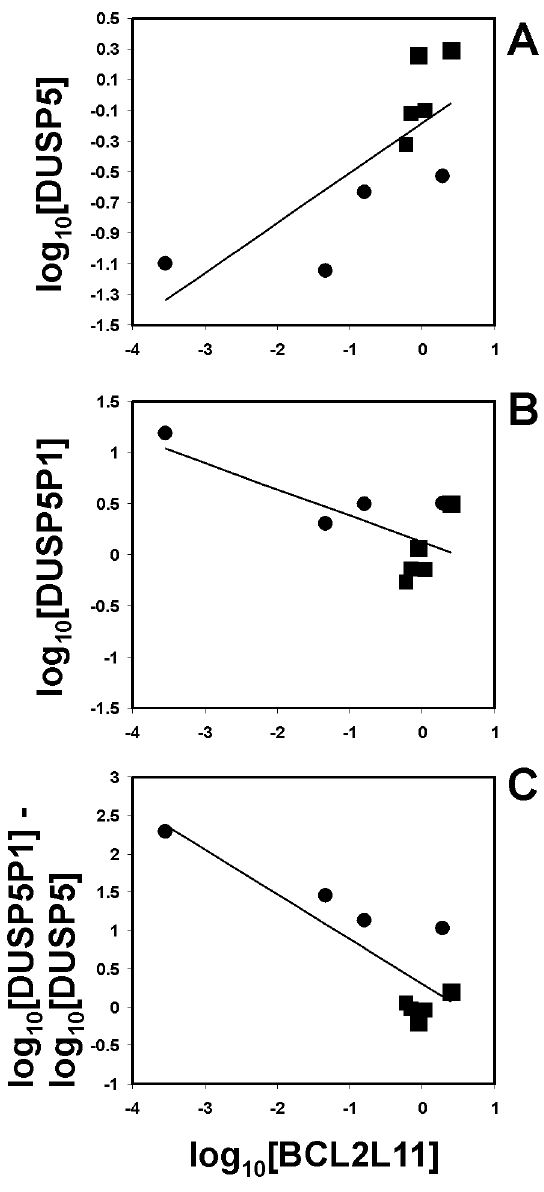
Figure 8. Correlation of DUSP5 and BCL2L11 expression in HL cells and PBMC. Quantitative RT-PCR was used for determination of expression of DUSP5, DUSP5P1, and BCL2L11 in normal PBMCs (squares; N=5) and HL cell lines (circles; N=5). For calculation of relative expression values, GAPDH was used as housekeeping control and the mean D ct value from 5 PBMC samples from healthy donors was set as 1. For cell line L-540 no expression of BCL2L11 was detected.